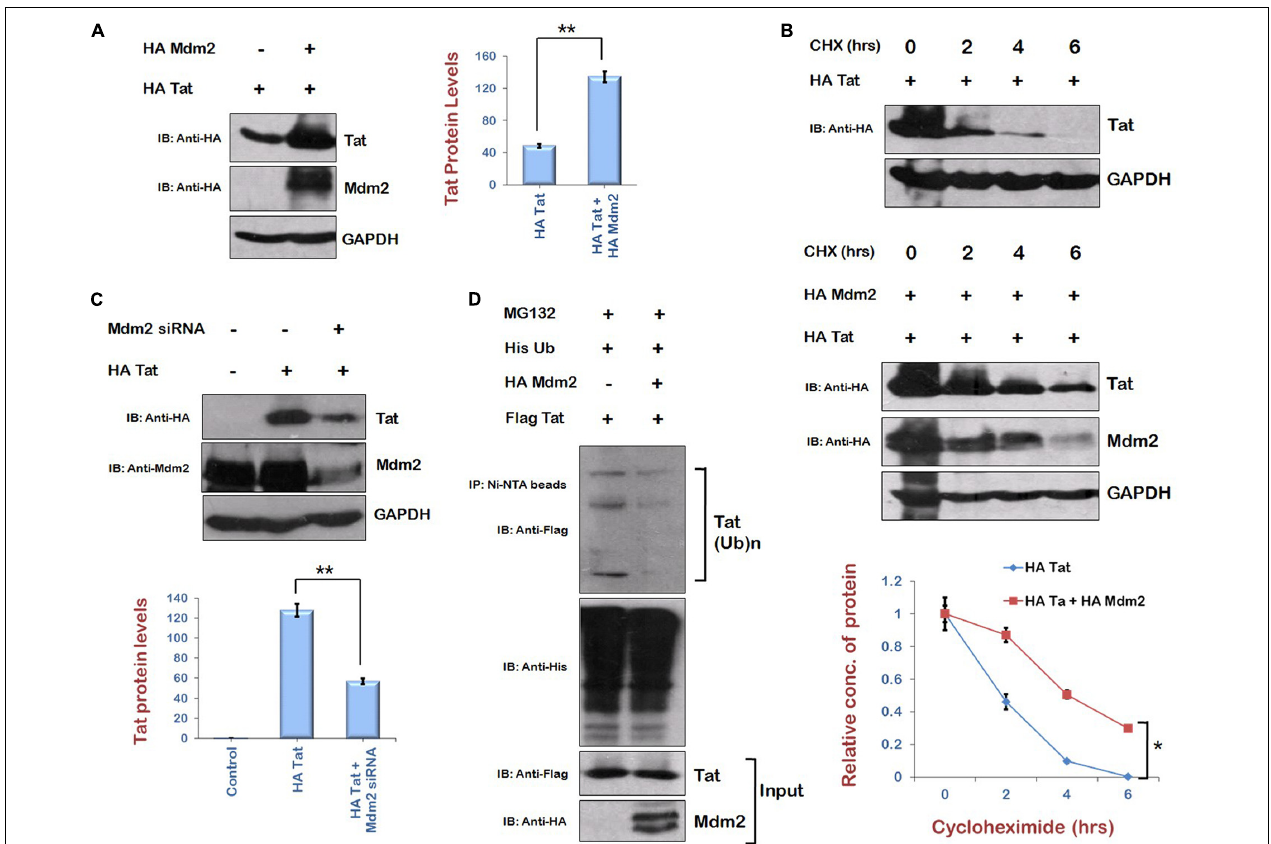
FIGURE 3 | Mdm2 stabilizes the expression of HIV-1 Tat in ubiquitin-dependent manner. (A) HEK-293T cells were transfected with HA Tat either alone or along with HA Mdm2 for 24 h. Cell lysates were subjected to Western blot analysis using anti-HA and anti-GAPDH antibodies. (B) HEK-293 T cells were transfected with HA Tat either alone or along with HA Mdm2 for 24 h. Cells were treated with cycloheximide (100 µ g/mL) for the indicated time periods. Cell lysates were subjected to Western blot analysis using anti-HA, anti-Myc, and anti-GAPDH antibodies. Densitometric analysis was done by ImageJ and shown as line graph with error bars. (C) HEK-293T cells were transfected with Mdm2 siRNA and HA Tat for 48 h. Cell lysates were subjected to Western blot analysis using anti-HA, anti-Mdm2, and anti-GAPDH antibodies. GAPDH was used as loading control. Densitometry analysis was performed using ImageJ and shown as bar graph with error bars. (D) HEK-293T cells were cotransfected with His Ub, Flag Tat, and HA Mdm2 for 24 h. Cells were treated with MG132 (20 µ M) for 8 h. Cell lysates were subjected to immunoprecipitation with Ni-NTA beads followed by Western blotting with anti-Flag antibody. Data obtained are presented as mean ± s.e.m. of three